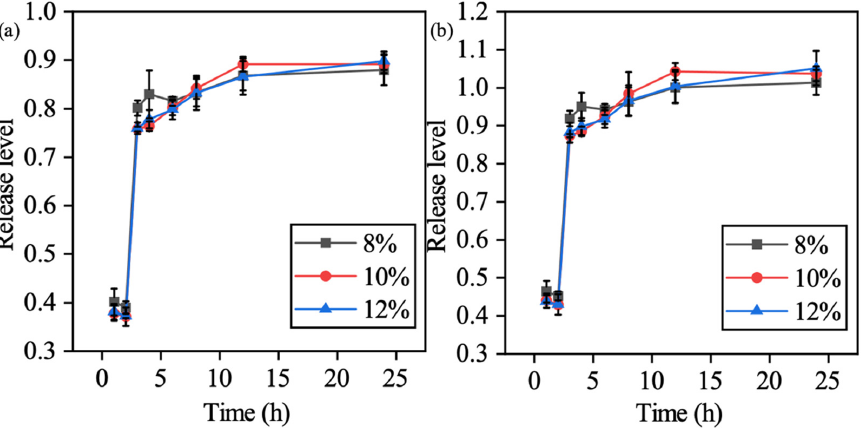
Figure 7. Cumulative release level for the standard dissolution test (pH switching at the second hour) of the lyophilized sample: ( a ) 504 nm and ( b ) 530 nm.